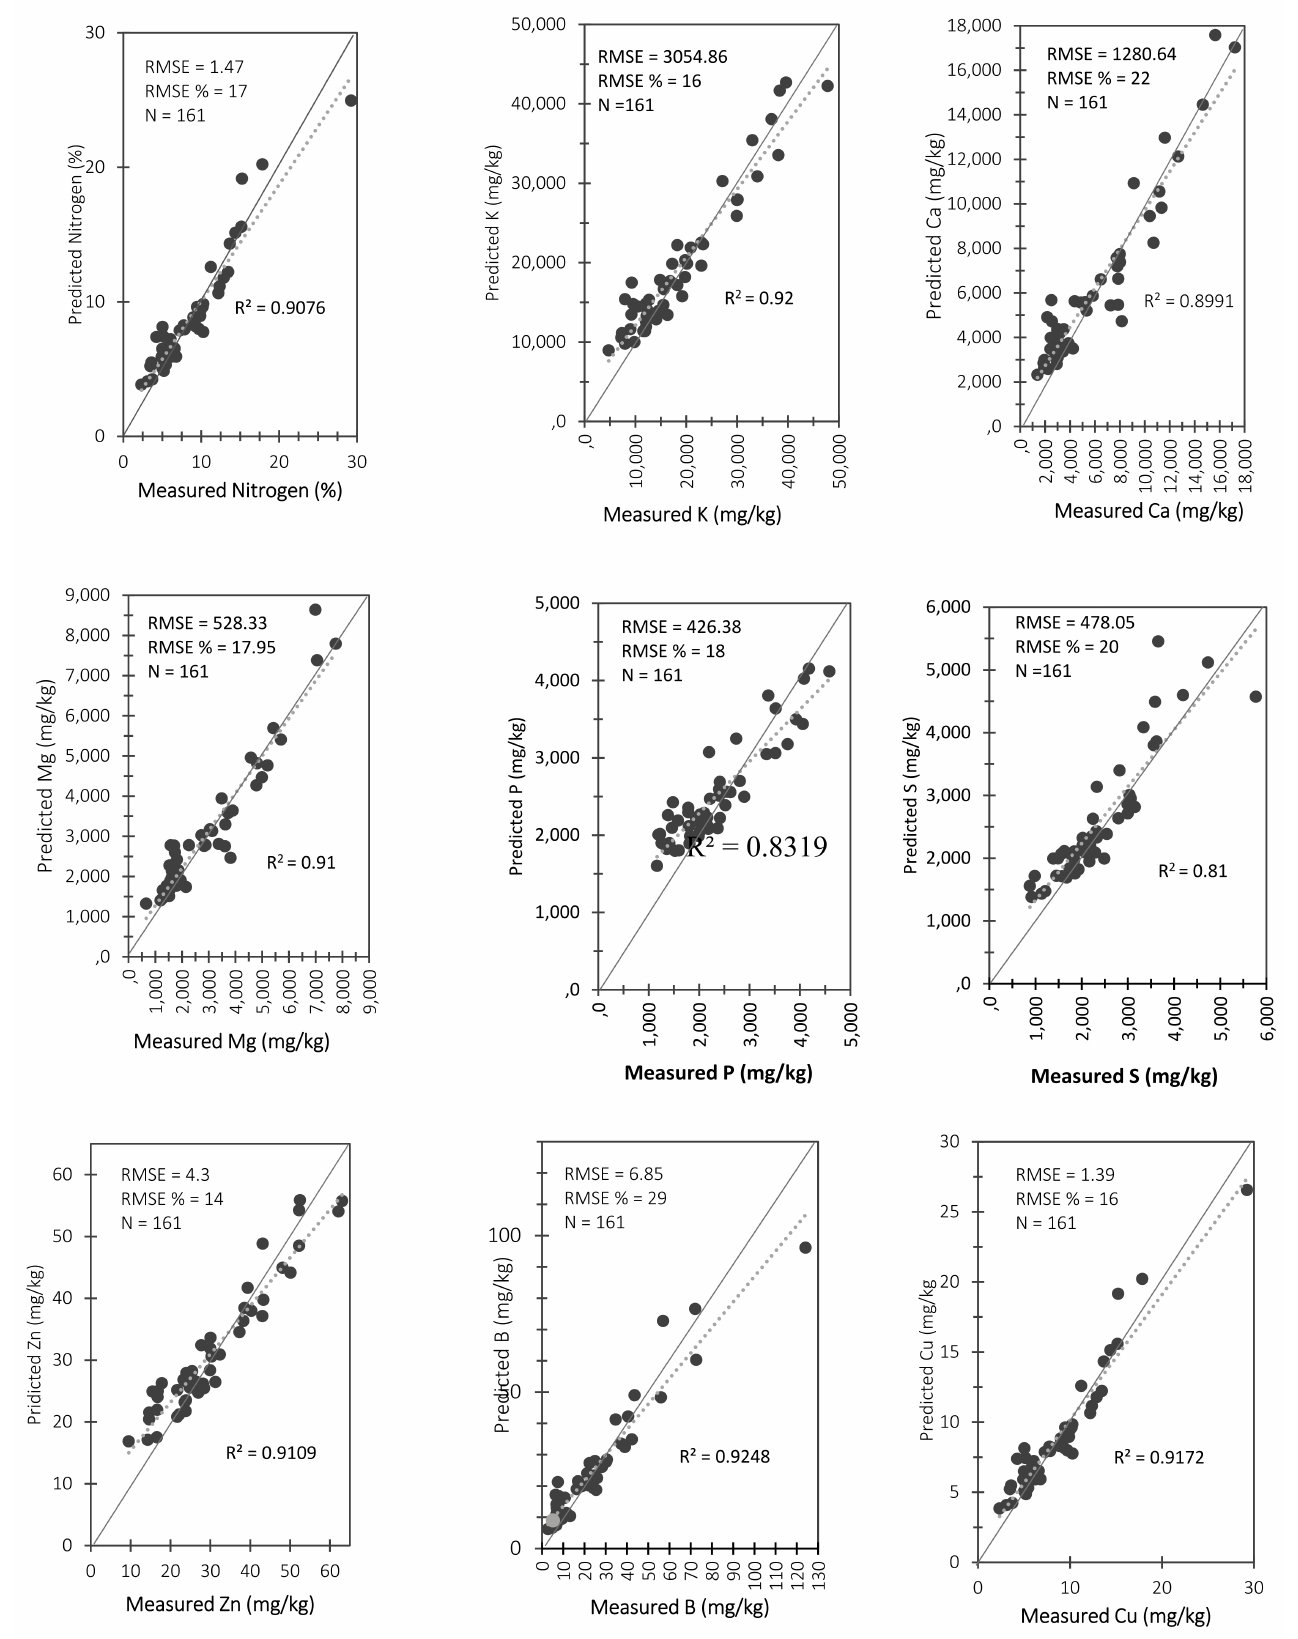
Figure 3. Accuracies derived in estimating N, K, Ca, Mg, P, S, Zn, B, Cu concentrations using testing data sets. Dotted lines in the graph illustrate the linear regression